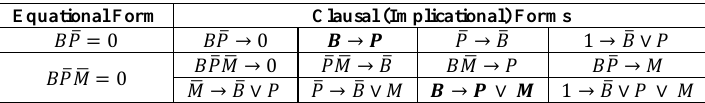
Table 4. Various clausal (implicational) interpretations of deduced equations Equational